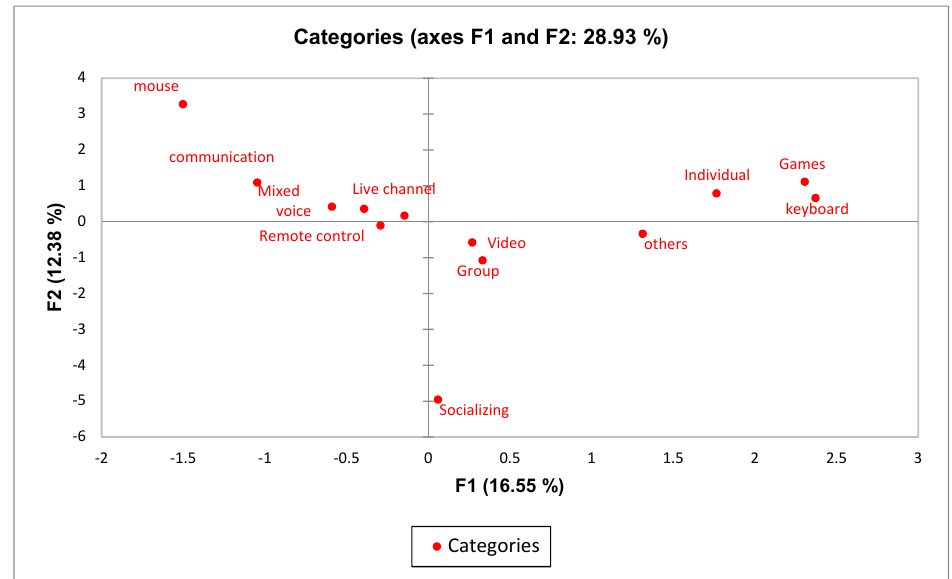
Figure 5. Multiple correspondence analysis (MCA) results for analyzing major activities on a smart TV.